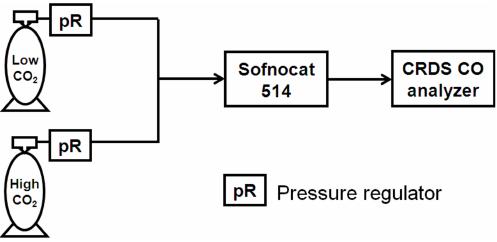
Fig. 5. Schematics of the CO 2 dependence test.